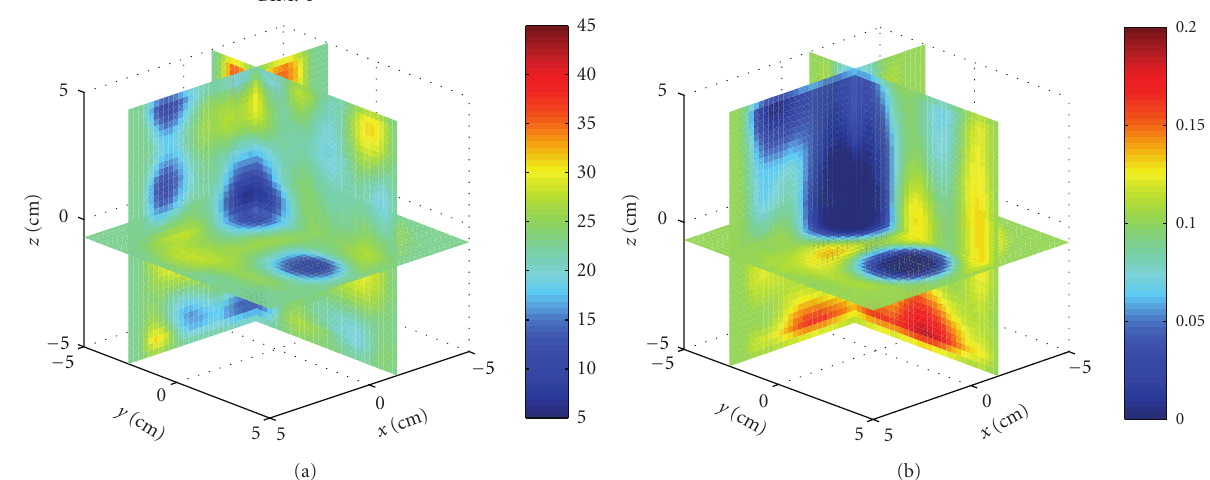
Figure 23: Reconstruction of the relative permittivity and conductivity of three acrylic spheres using a cavity operating at 915 MHz from Experiment 2. The two spheres in plane are well recovered and the third detected at the upper left of the